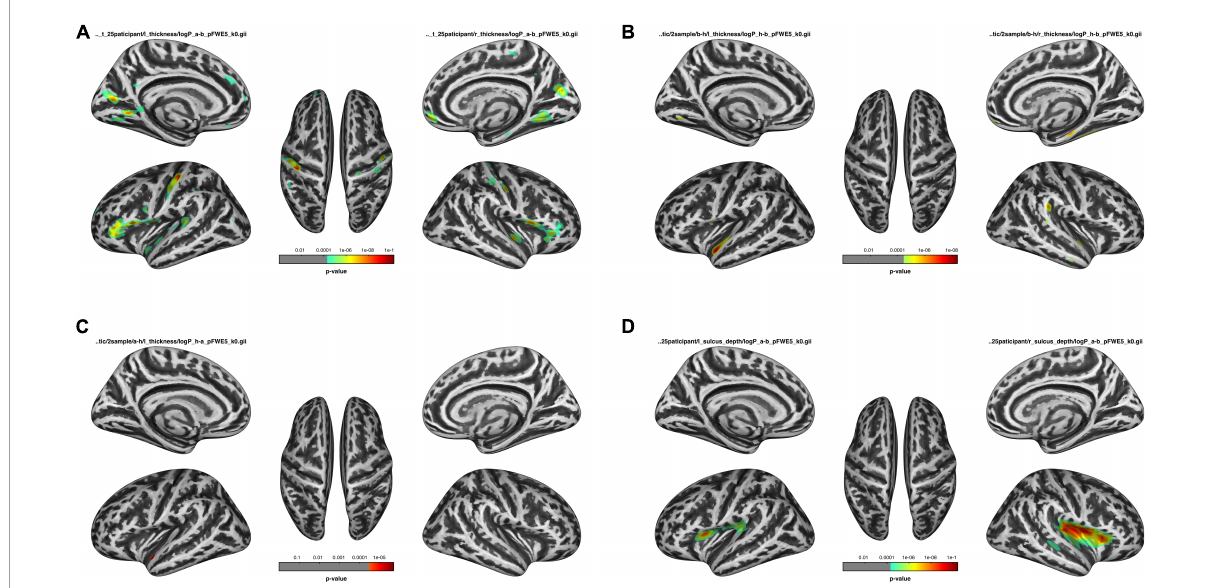
FIGURE1 Comparison of before HD (HDb), after HD (HDa), and healthy control (HC) groups. (A) Comparison of the thickness of the HDa group with that of the HDb group. (B) Comparison of the thickness of the HDb group with that of the HC group. (C) Comparison of the thickness of the HDa group with that of the HC group. (D) Comparison of the sulcus of the HDa group with that of the HDb